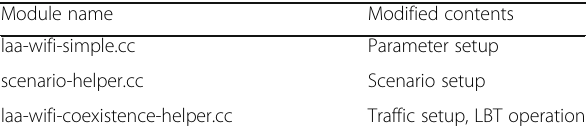
Table 2 Modified NS-3